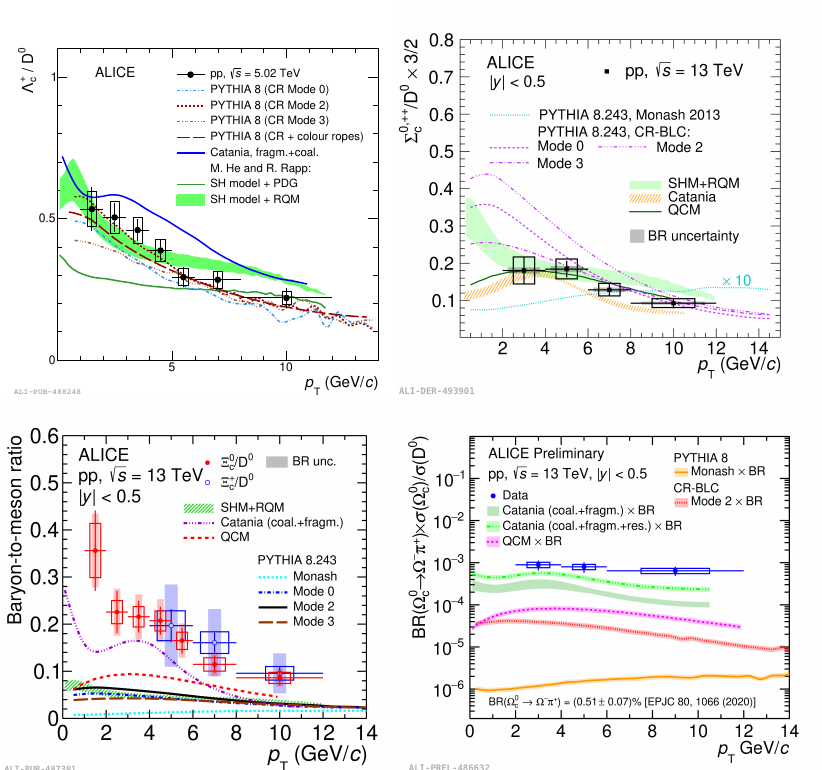
Figure 1: The results of charm baryon-to-meson ratios are compared with different theoret- / D 0 ratio measured in pp collisions at ical predictions. Top-left: The Λ + (cid:112) c / D 0 in pp collisions at s = 13 TeV [ 3 ] . Bottom-left: Ξ 0 Top-right: Σ 0, ++ , + (cid:112) c s = 13 TeV [ 4 ] . Bottom-right: BR × Ω 0 ratios at a function of p in pp collisions at (cid:112) T s = 13 at a function of p in pp collisions at T